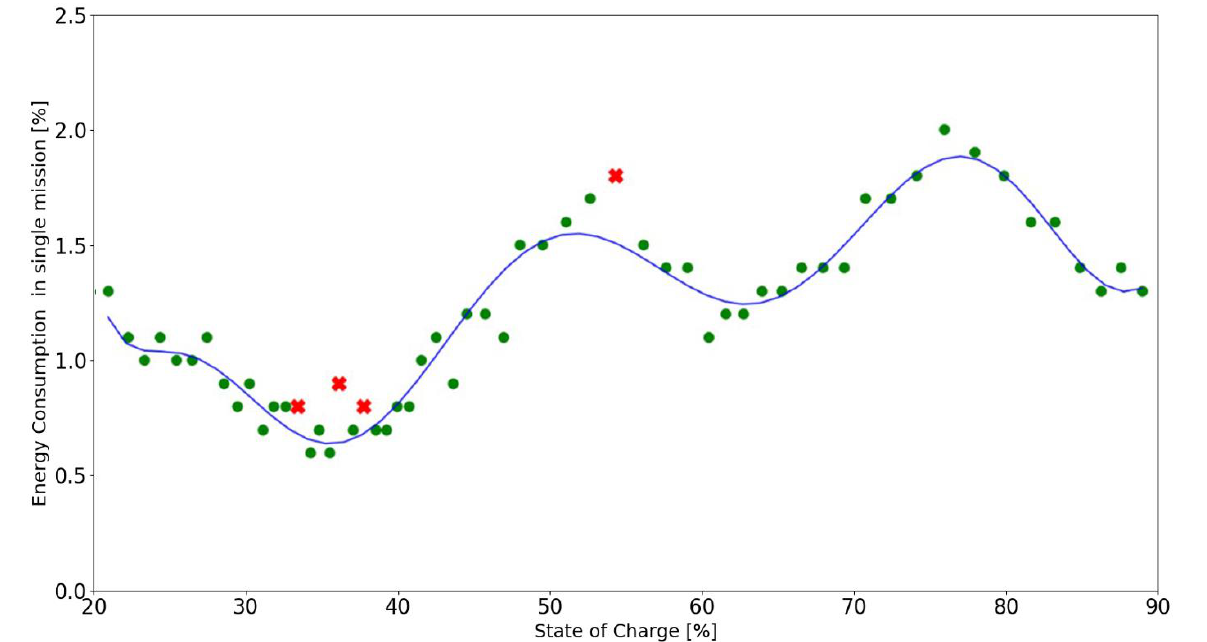
Figure 12. Energy consumption in experimental scenario 1, where ● represent the correctly executed missions and the ❌ represent the incorrectly executed ones.